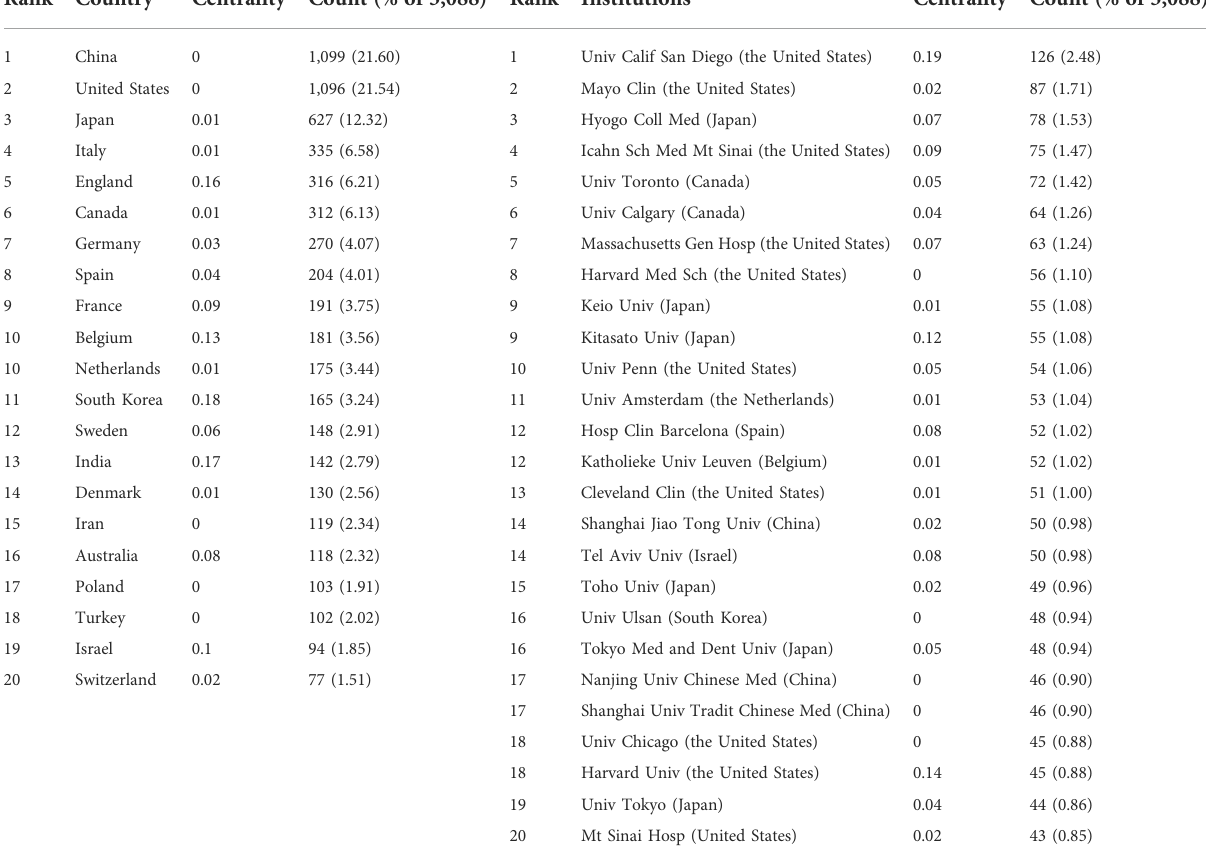
TABLE 1 Top productive 20 countries or regions and institutions involved in UC